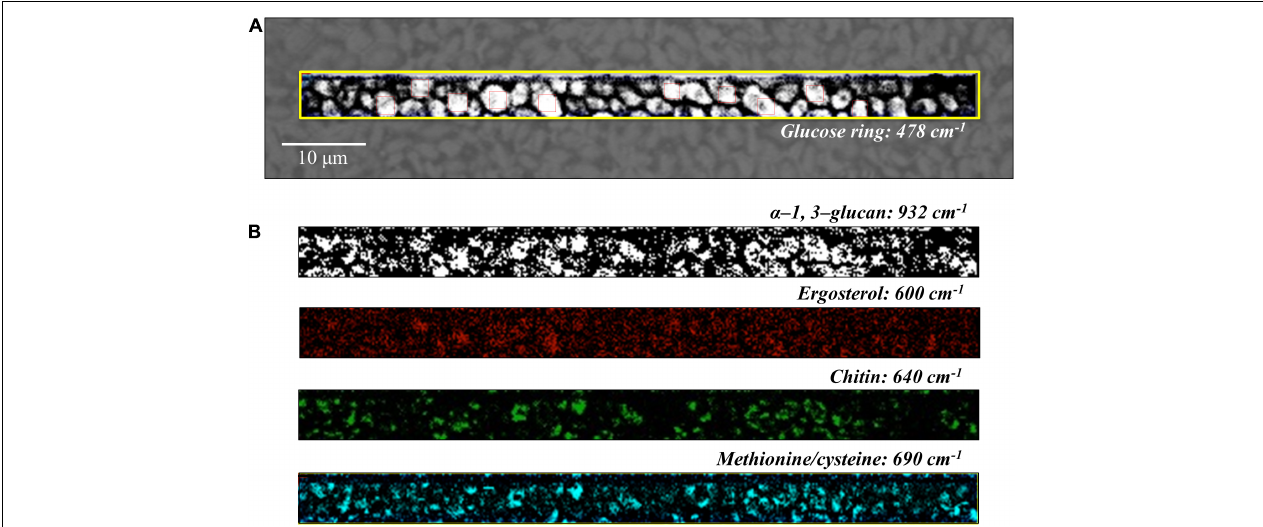
FIGURE 6 | (A) Optical micrograph and Raman map of glucose rings in membrane polysaccharides at 478 cm − 1 (in the yellow square region) of C. auris (Clade III) culture; in (B) from top to bottom (cf. labels), α -1, 3-glucans at 932 cm − 1 (white spots on black background), ergosterol at 600 cm − 1 , chitin at 640 cm − 1 , and S-containing amino acids at 690 cm − 1 . The maps in (B) correspond to the same square region in (A) . The 10 smaller square areas located in (A) represent the regions used for PCA analyses.